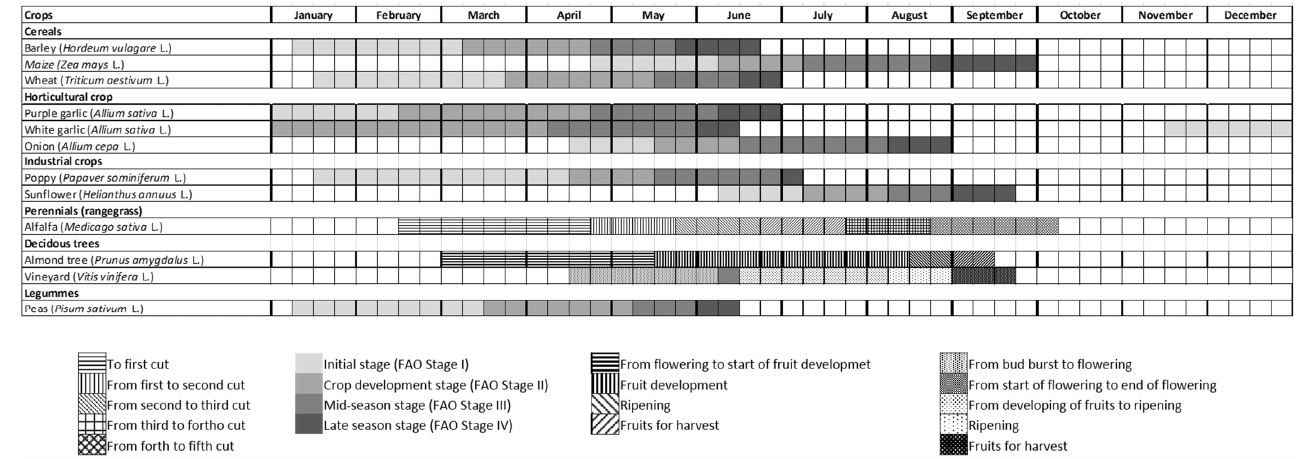
Figure 7. Growing cycles of studied crops for the case study.